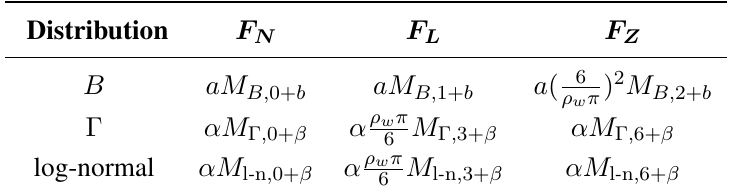
, F and F for the different N L Z